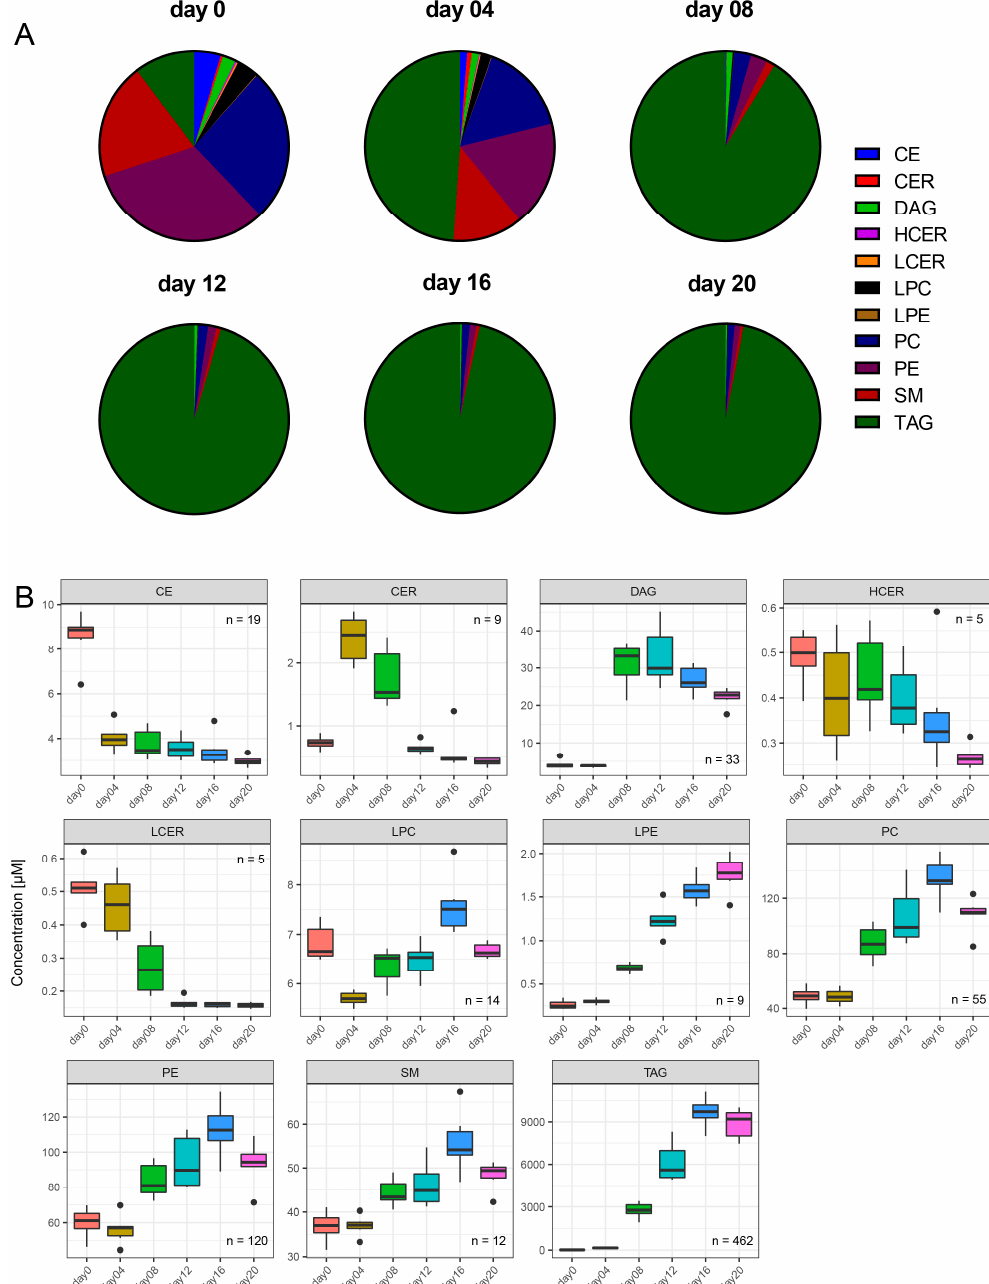
Figure 2. Changes in lipid class compositions and concentrations in specific lipid classes in the course of adipogenesis showed enormous lipid remodeling during the ongoing differentiation process. A : Relative lipid class compositions at different days of adipogenesis in molarity %. Prior to differentiation at day 0, a very heterogeneous class distribution could be observed. This composition became more uniform during adipogenesis due to the predominance of triacylglycerols (TAG). The relative fraction for TAG increased from 10.3 ± 0.5 molarity % at day 0 to 96.9 ± 0.4 molarity % at day 20. B : The concentration profiles of different analyzed lipid classes showed individual time courses during ongoing adipogenesis. Cholesteryl esters (CE), HCER, and LCER concentrations decreased strongly during adipogenesis, whereas LPE, PC, PE, and TAG concentrations strongly increased. Ceramide (CER) concentrations increased from day 0, peaking at day 4, and then decreased below the starting concentration levels. DAG species had their concentration maximum from days 8 to 12. LPC fluctuated during the whole differentiation process.